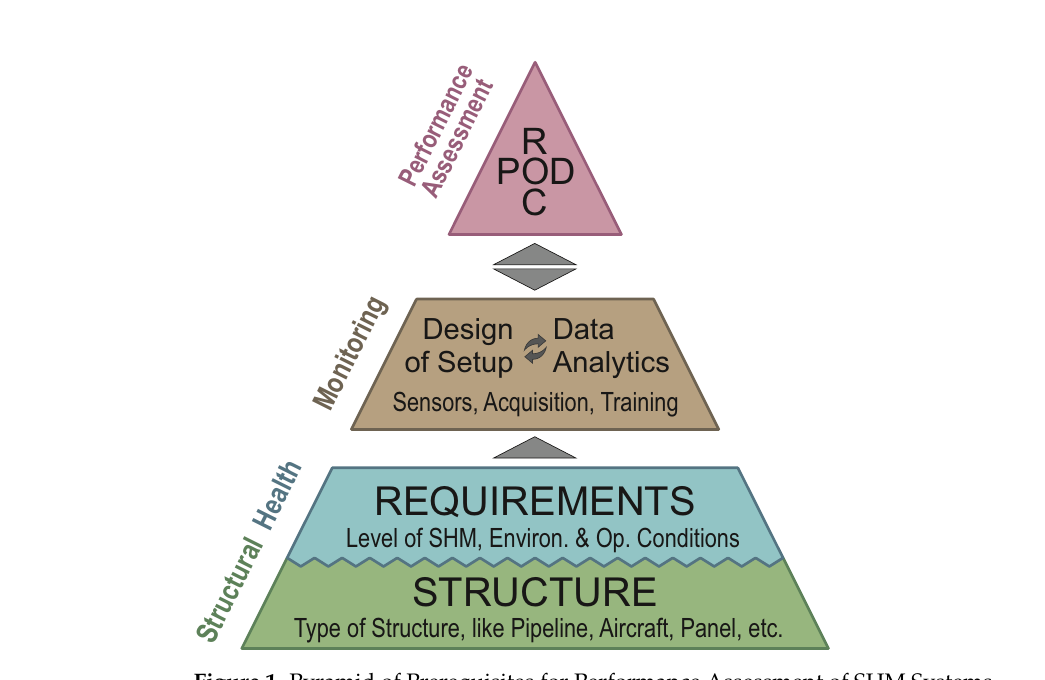
Figure 1. Pyramid of Prerequisites for Performance Assessment of SHM